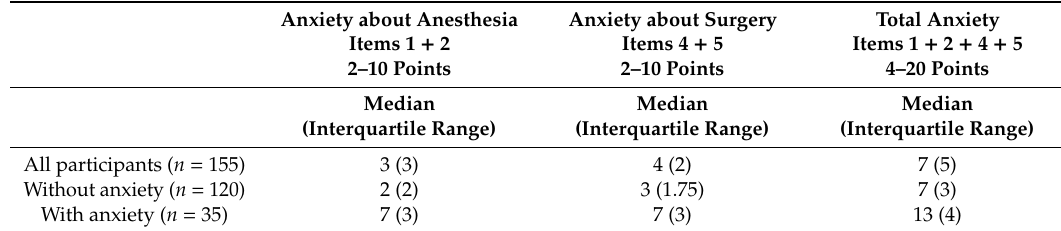
Table 2. Scores obtained in the Amsterdam preoperative anxiety and information scale (APAIS) anxiety subscale.